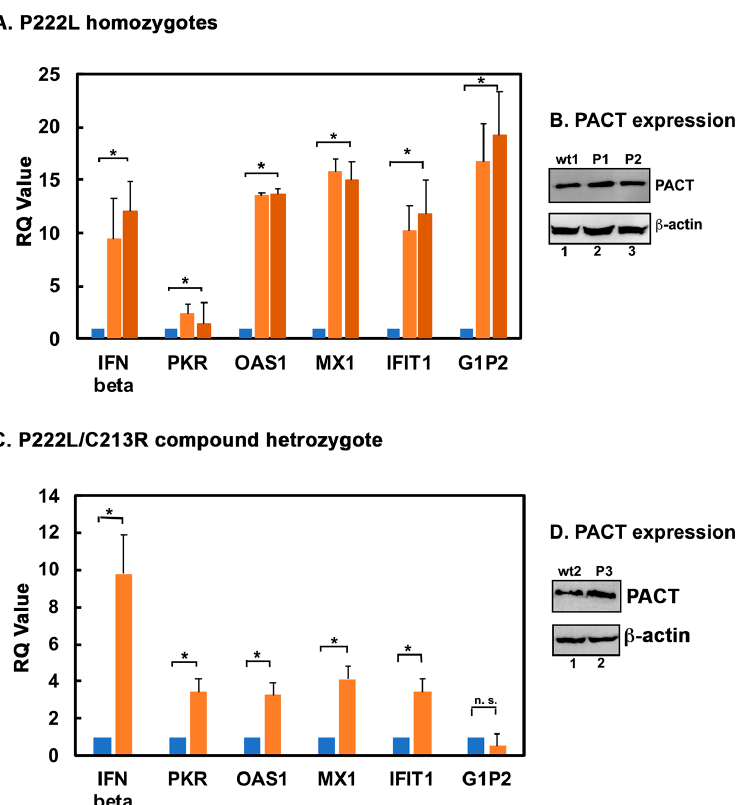
Figure 3. DYT- PRKRA patient lymphoblasts express higher basal levels of IFN β and ISG mRNAs. Quantitative RT-PCR of a panel of IFN β and 5 ISGs in lymphoblasts established from DYT- PRKRA patients (orange bars) and unaffected family members (blue bars). The RQ values indicate that IFN β and ISG expression was upregulated (* p < 0.001, indicated by asterisk) in DYT- PRKRA cells compared to unaffected control cells. ( A ) qRT-PCR analysis of two P222L homozygous patients and one unaffected individual. IFN β and all ISGs were upregulated in DYT- PRKRA patient samples. ( B ) Western blot analysis. Whole cell extracts prepared from wt (wt1) and patient (P1 and P2) lymphoblasts were analyzed by Western blot analysis. Blots were probed with anti-PACT, and anti- β - actin antibodies with β -actin used for ensuring equal loading in all samples. ( C ) qRT-PCR analysis of one compound heterozygous DYT- PRKRA patient and one unaffected family member. IFN β